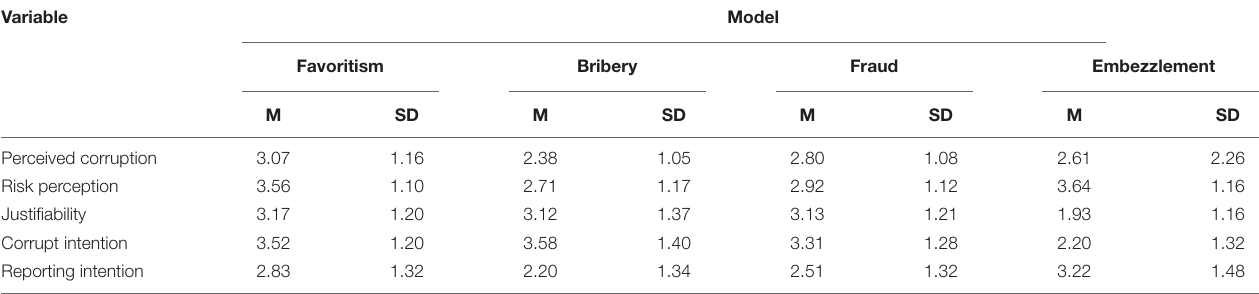
TABLE 1 | Mean and standard deviation for model’s variables. Variable